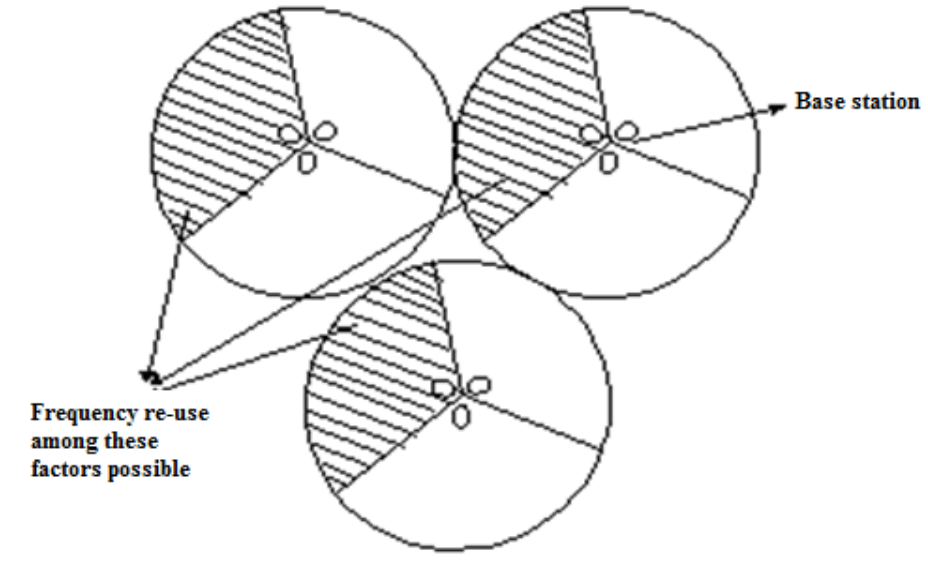
Fig. 4. Cell sectoring [Wireless in local loop,